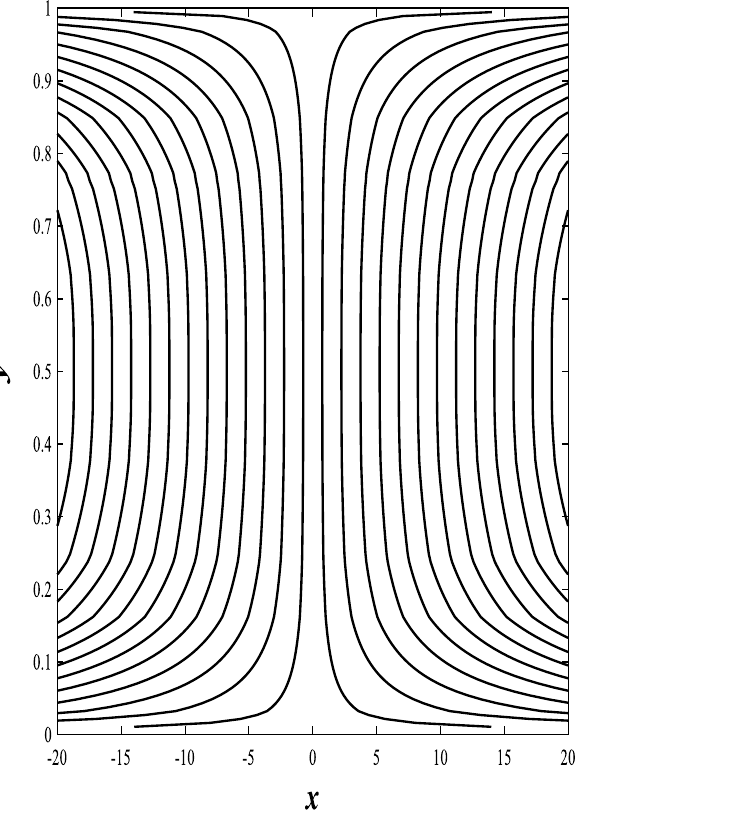
lines under the influence of two different values of the magnetic field parameter M when the values of the rest 0.6 . It was found that the convergence in the streamlines at the of the physical parameters are constant at F = 1.5 and that congestion in the streamlines occurs at the lift side of the channel at right side of the channel at M = 2.5 with two boluses occurring right and left the walls of the channel. Figures 38 and 39 show the behavior M = of the fluid’s streamlines during its flow in the channel when the Darcy number takes two different values while 0.6 . The symmetry and regularity of the stream- the values of the rest of the parameters remain constant at F = 1 , as well as the occurrence of symmetry of the lines on both sides of the channel were observed when Da = 1.5 . Finally, streamlines around the channel axis with convergence on the right side of the channel when Da = 0.5 and (cid:31) 1 on the streamlines at Figs. 40 and 41 display the effect of two different values of rotation (cid:31) = =